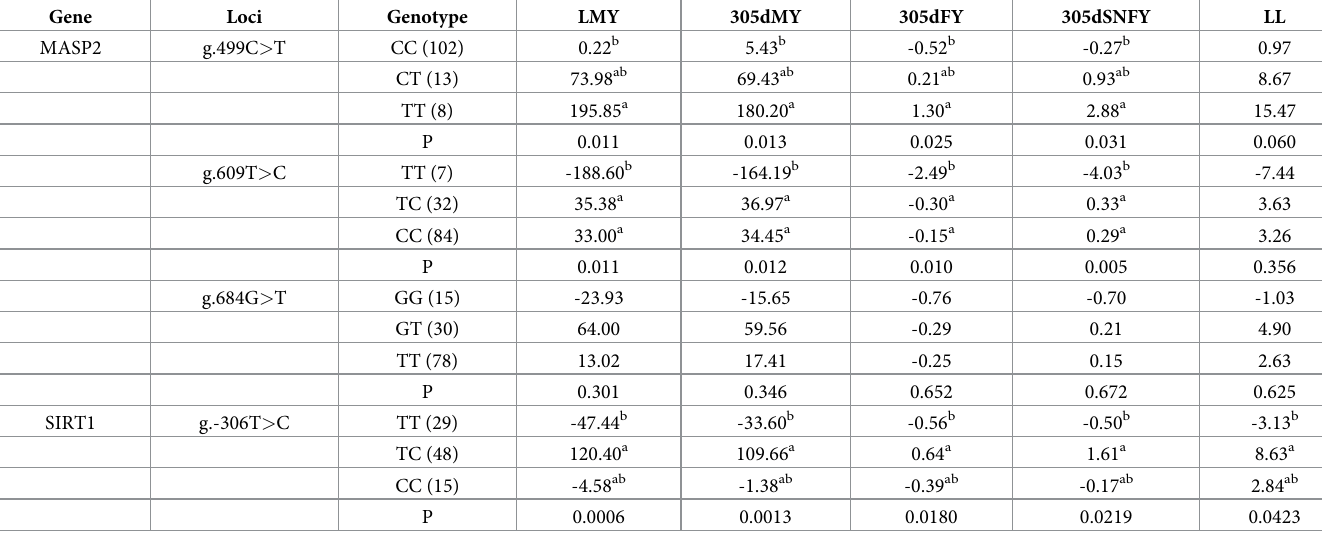
EBV of LMY, 305dMY, 305dFY and 305dSNFY (P < 0.0058–0.0256) in Sahiwal cows, respec- tively. Interestingly, the TT genotype of SNP g.499C > T locus possessed the highest EBV for all milk yield traits, indicating that the mutant allele T was associated with superior milk perfor- mances in the studied population. On the other hand, CC genotyped cows associated with the lowest EBV for the traits studied. While, the EBV of CT genotyped cows found to be intermedi- ate as compared to TT genotypes. For the SNP change at position g.609T > C, the TC and CC genotyped cows had significantly higher estimated breeding value of the studied traits as com- pared to TT genotype, indicating that allele C was associated with superior genetic merit for milk yield traits (Table 4). However, these two SNPs did not show significant effect on the EBV of LL (P values > 0.05) of Sahiwal cows. Curiously, this SNP locus could become a crucial molecular and genetic marker as it showed a significant impact on all the EBVs of milk yield traits under the study. These results offer overwhelming evidence to the research in to genetic markers, in particular markers associated with the improvement of milk yield traits in Zebu cat- tle breeds. The EBV of GT genotyped cows at the SNP g.684G > T locus appeared to be high in magnitude, but statistically not significant (P < 0.05). No studies about the association of these specific SNPs of bovine MASP2 gene on various traits in livestock (especially in cattle) were available, so that evidences have not been drawn from the literature. In the present study, the association analysis revealed that SNP g.-306T > C in SIRT1 pro- moter region was strongly associated (P < 0.0006–0.0423) with EBVs of LMY, 305dMY, 305dFY, 305-dSNF and LL in Sahiwal cattle population. To put it in another way, EBVs of TC genotype cows was significantly higher than those of CC and TT genotype cows, respectively (Table 4). In case of SIRT1 gene, TT genotype cows demonstrated the lowest lactation perfor- mance in Sahiwal cattle. In this regard, our results confirmed that the priority of genomic and inbreed selection should be held on heterozygous states as compared to homozygous ones. The heterozygote TC is phenotypically different from the homozygote TT and CC because it has a higher value for a production trait or has a phenotype thought to be important for the